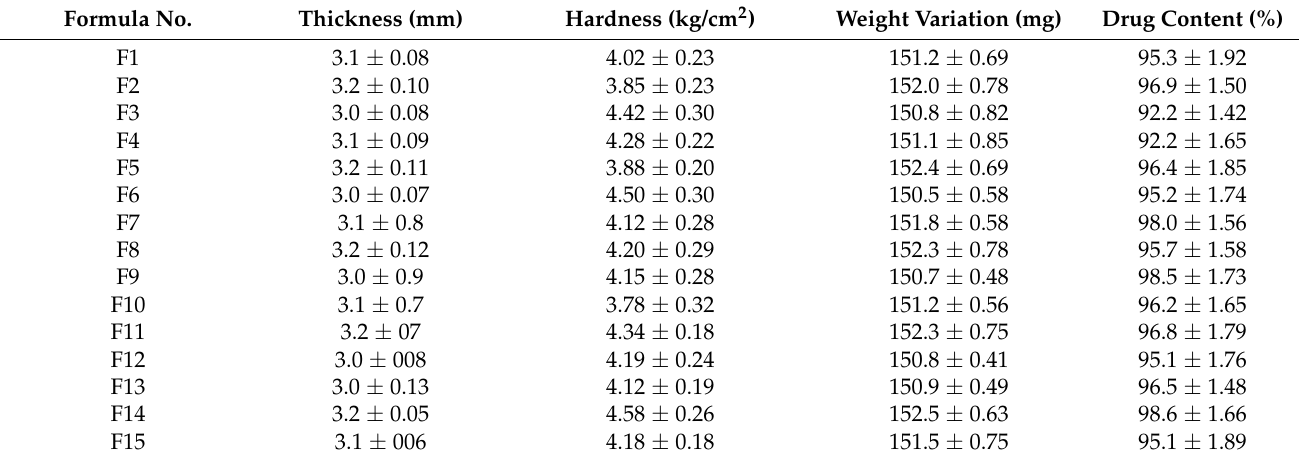
Table 4. Post- compression parameters of preliminary batches Fl-F15.